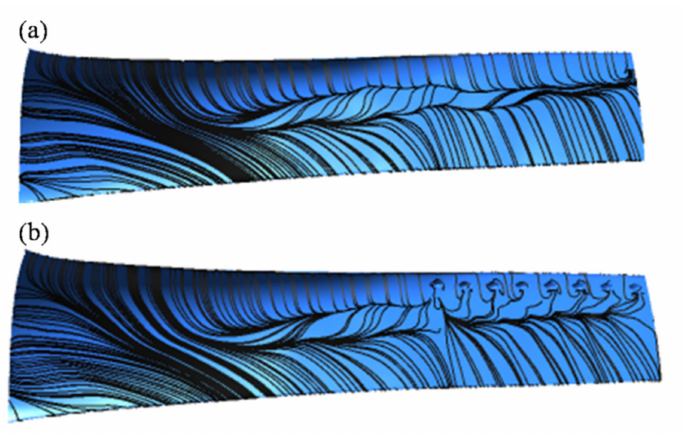
Figure 8. Limiting streamlines on the suction side at case 2: ( a ) original blade and ( b ) test 3.